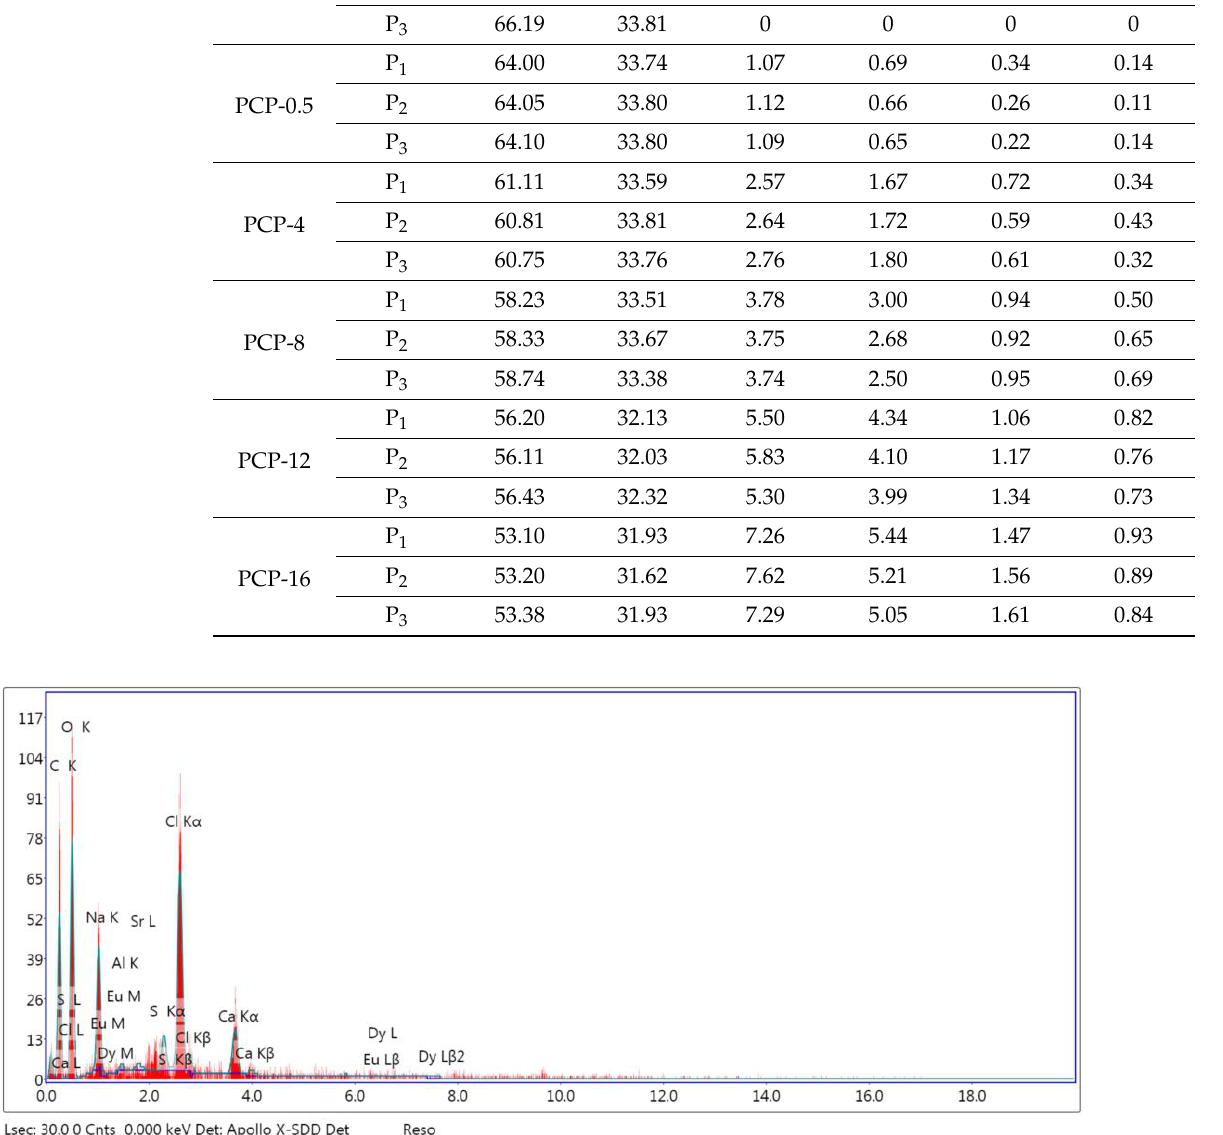
Figure 6. EDX spectra of PCP-4. Table 1. Elements (wt%) monitored by EDX of SAPN@PCP at three separate points (P 1 , P 2 and P 3 ). Table 2. Elements monitored by XRF in SAPN@PCP.